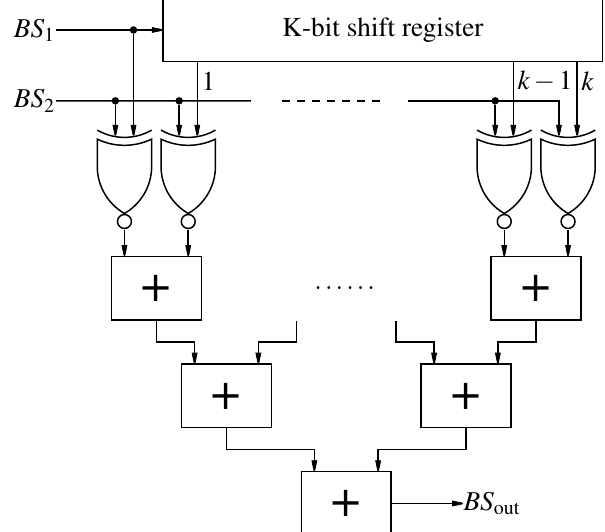
Figure 21. Multiplication of two bit-streams based on Delta Adder